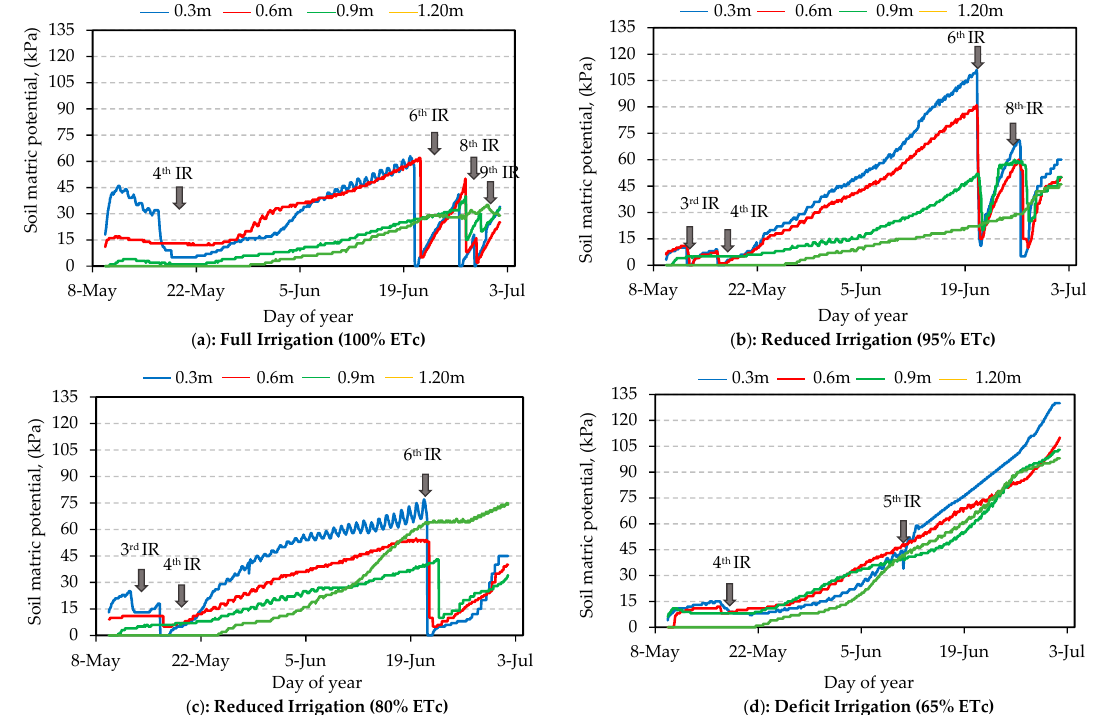
Figure 8. Soil matric potential for the hourly measurements from the four Watermark sensors within the 120 cm soil depth (soil water tension starts to increase above 0 kPa as the soil starts to dry below saturation) for ( a ) zone A 2 , ( b ) zone B 2 , ( c ) zone C 2 , and ( d ) zone D 5 , irrigation events (IR) indicated by arrows.